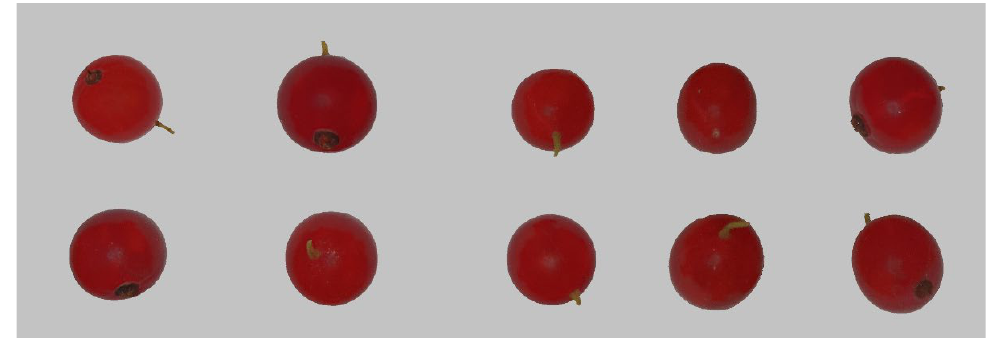
Figure 1. Exemplary images of unstored red currants at the beginning of the experi-